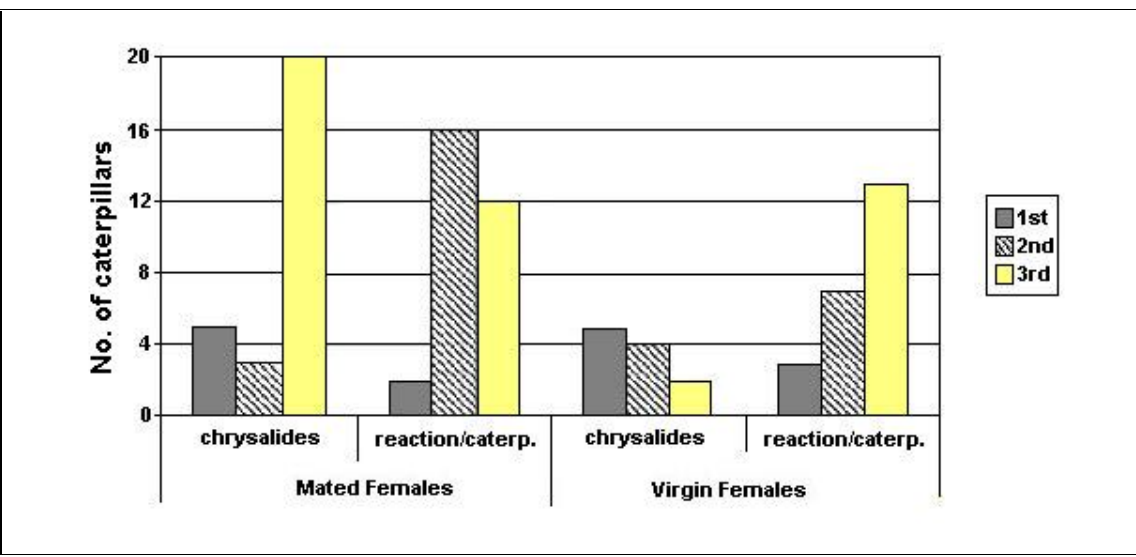
Figure 2: Number of Diatraea saccharalis caterpillars parasitized by mated and virgin Cotesia flavipes females that underwent metamorphosis (chrysalides), and number of hosts that encapsulated parasitoid eggs and larvae in each oviposition (reaction/caterp.).